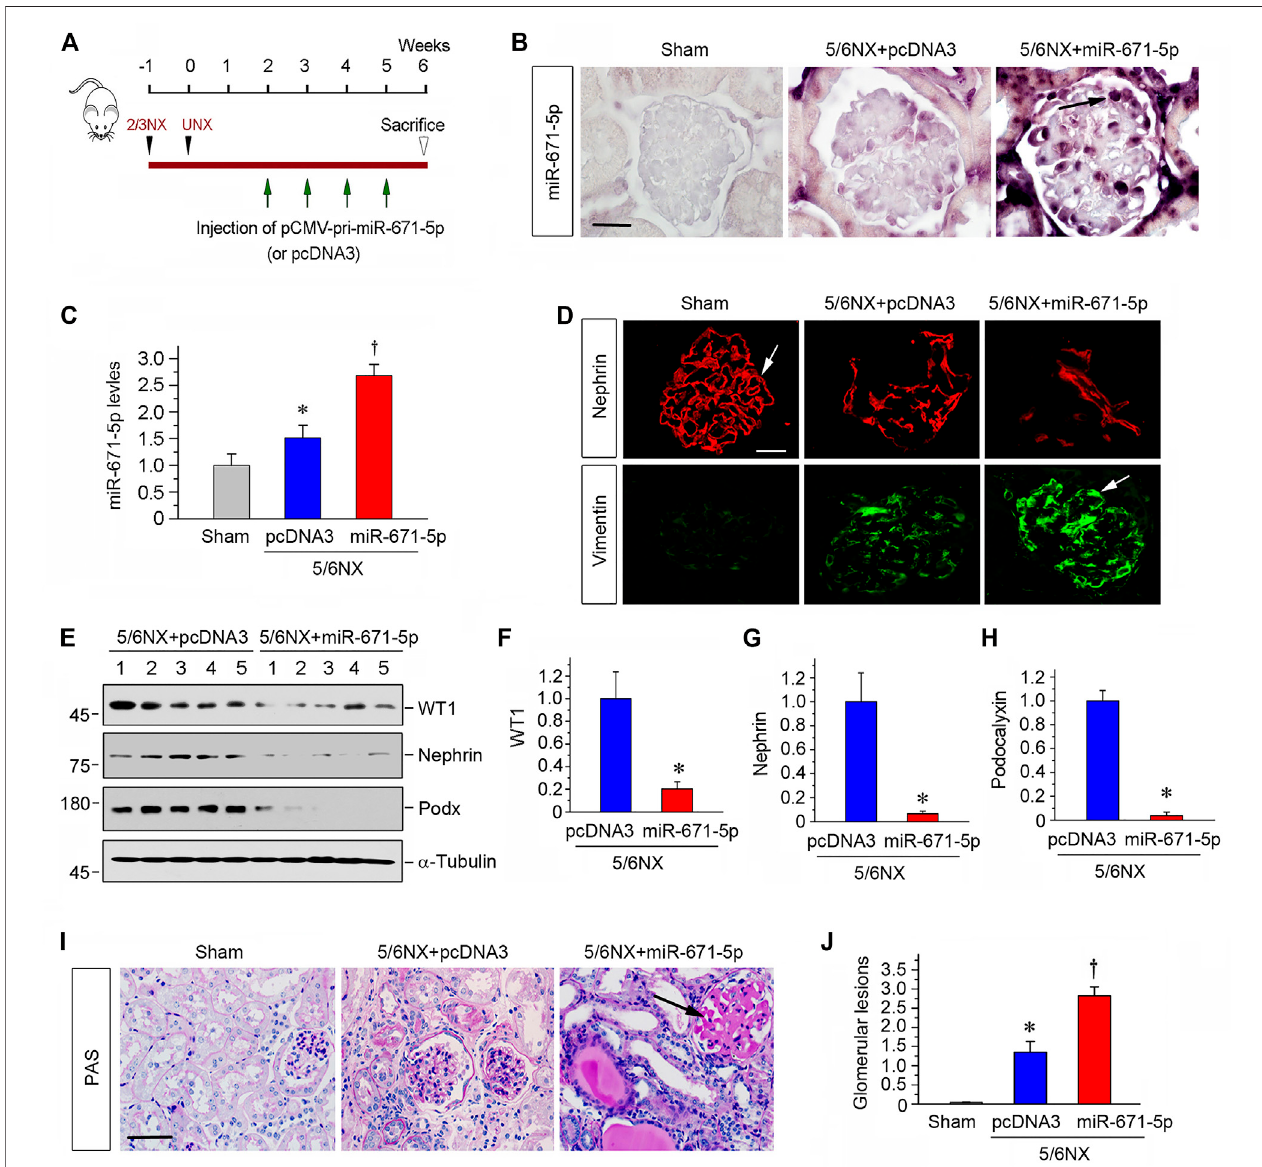
FIGURE 4 | Ectopic expression of miR-671-5p accelerates podocyte injury and glomerulosclerosis in 5/6NX model. (A) Experimental design. Black Arrowheads indicatethetimeofkidneyresection.GreenarrowsindicatetheinjectionsofpCMV-pri-miR-671-5porpcDNA3plasmid. (B) RepresentativemicrographsshowmiR-671- 5p expression in glomerular podocytes in 5/6NX model by in situ hybridization. Scale bar, 20 µm. (C) qRT-PCR analysis of miR-671-5p levels in different groups as indicated.* p < 0.05versusshamcontrols; † p < 0.05versus5/6NXalone( n (cid:1) 5 – 6). (D) Immuno fl uorescencestainingshowrenalexpressionofnephrinandvimentin in different groups as indicated. Frozen kidney sections were stained for nephrin and vimentin. Scale bar, 20 µm. (E – H) Representative Western blot (E) and graphic presentations of WT1 (F) , nephrin (G) and podocalyxin (H) were presented. * p < 0.05 ( n (cid:1) 5 – 6). (I) Representative micrographs show periodic acid-Schiff (PAS) staining of the kidneys in different groups. Scale bar, 50 µm. (J) Quantitative determination of glomerular lesions (based on PAS staining) in different groups. * p < 0.05 versus sham controls, † p < 0.05 versus 5/6NX ( n (cid:1) 5 – 6).